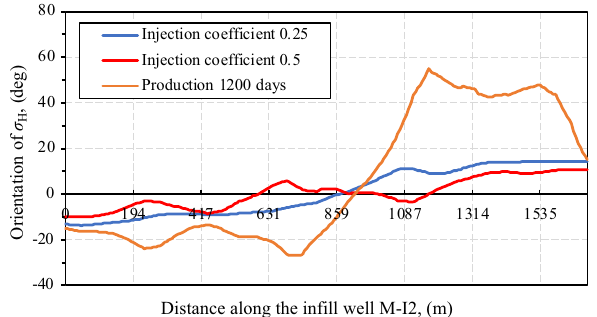
Fig.11 The orientation of maximum horizontal stress along the M-I2 wellbore at different injection